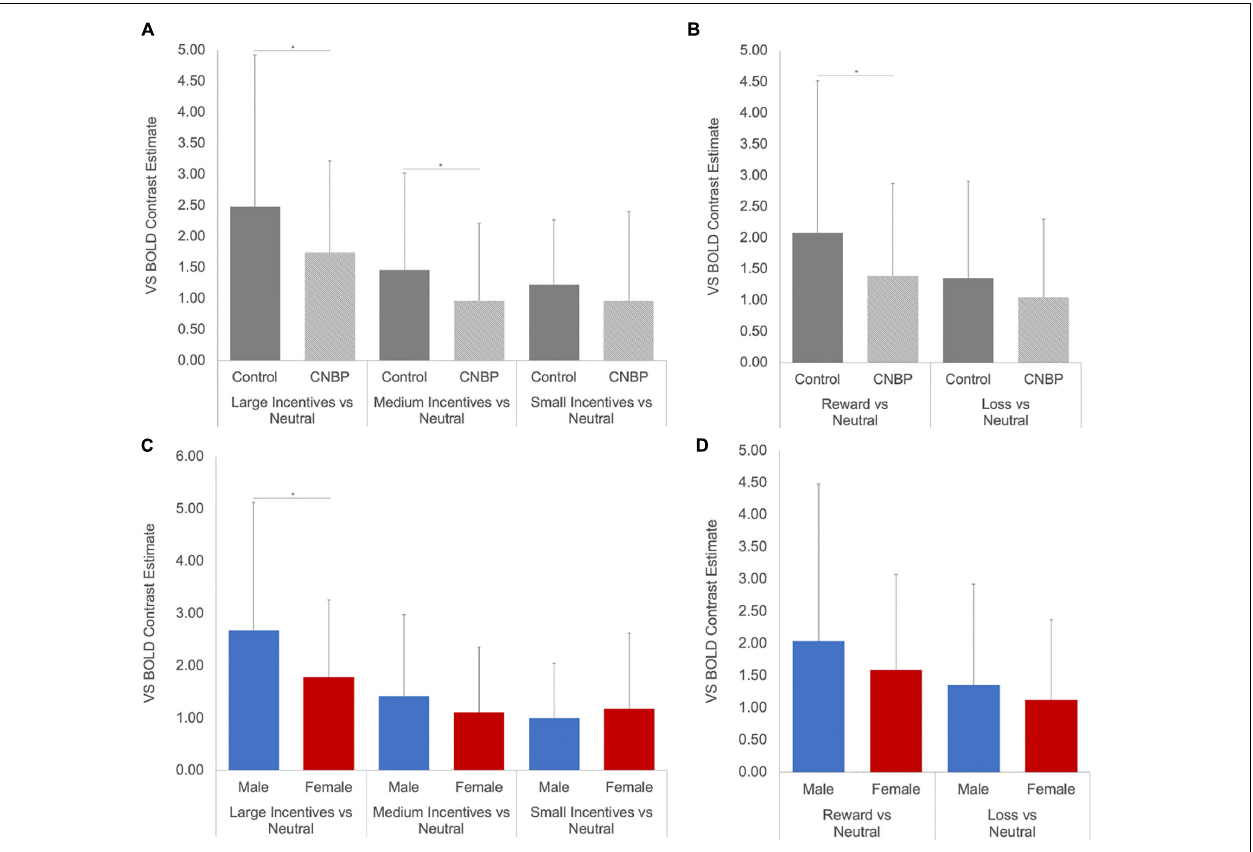
FIGURE 2 | Ventral striatal responses to incentive anticipation vary by sex and group. Bars represent ventral striatal response to anticipation of each incentive broken down by sex or group then examined as a function of salience and valence. (A) , Salience-by-Group; (B) , Valence-by-Group; (C) , Salience-by-Sex; (D) , Valence-by-Sex. Error bars represent confidence intervals. VS, ventral striatum. * denotes significant